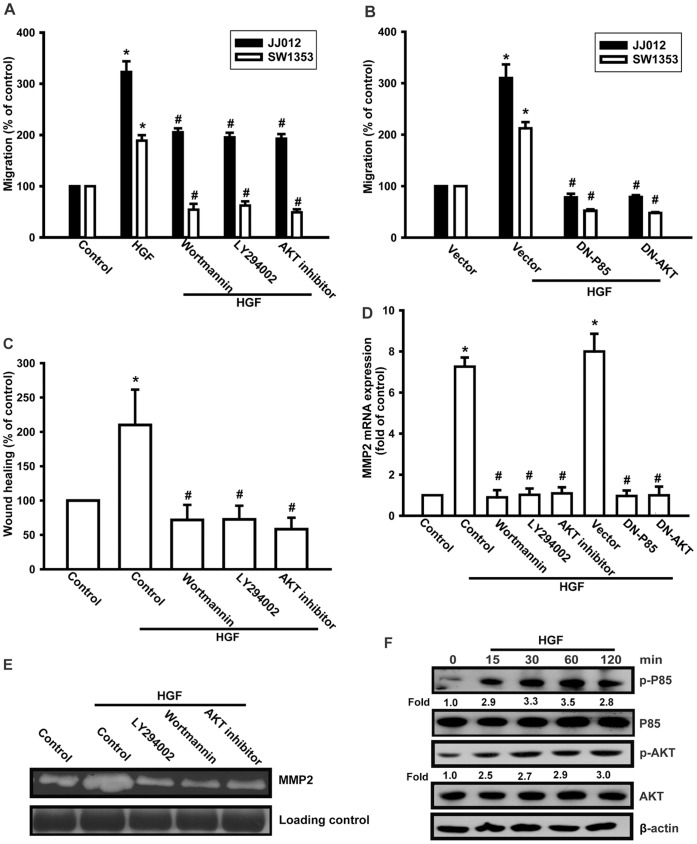
Involvement of PI3K/Akt signaling pathway in response to HGF in chondrosarcoma cells.(A–E) Cells were pretreated for 30 min with Ly294002 (10 µM), wortmannin (1 µM), and Akt inhibitor (1 µM) or transfected with dominant negative (DN) mutants of p85 and Akt for 24 h, followed by stimulation with HGF; cell migration and MMP-2 expression were then examined by Transwell, wound healing, qPCR, and zymography assays. (F) JJ012 cells were incubated with HGF for the indicated time intervals, and p-p85 and p-Akt expression was determined by western blotting. Results are expressed as mean ± S.E. *p<0.05 compared with control; #p<0.05 compared with HGF-treated group.